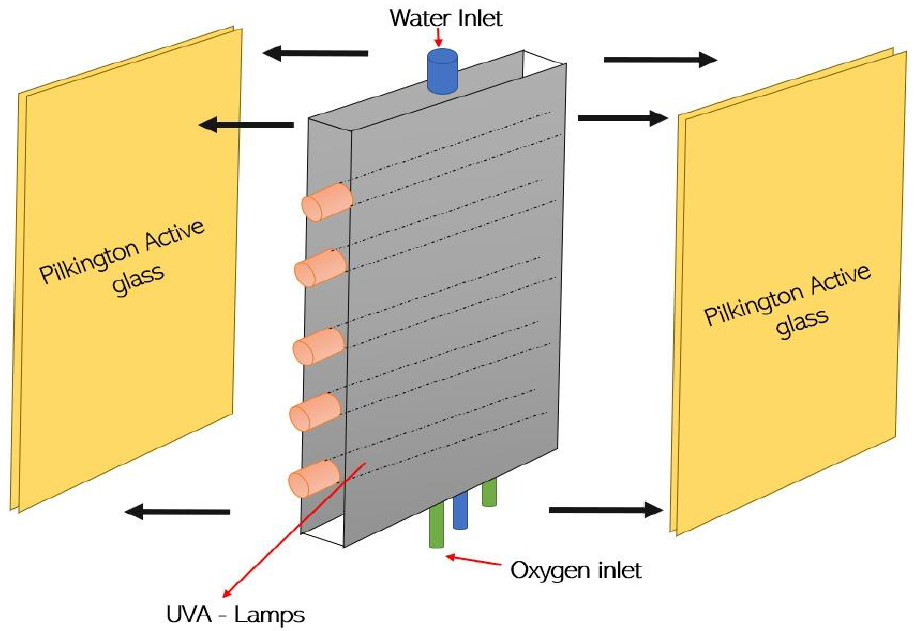
Figure 6. Scheme of UV disinfection process.